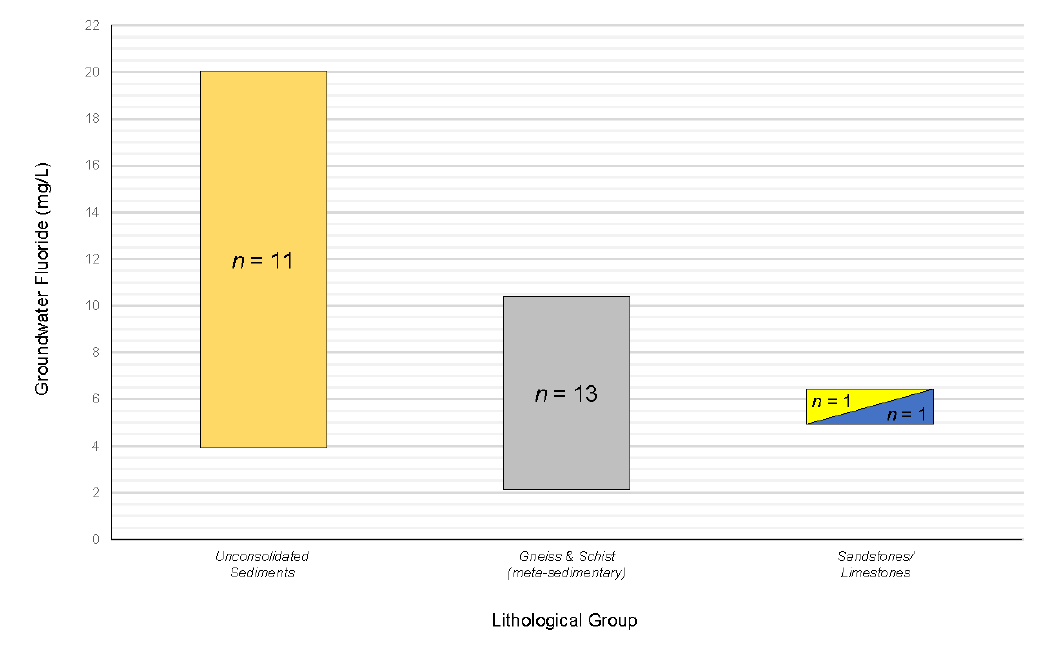
Figure 5. Groundwater fluoride concentration ranges for hot springs, split per lithological group from which they occur.